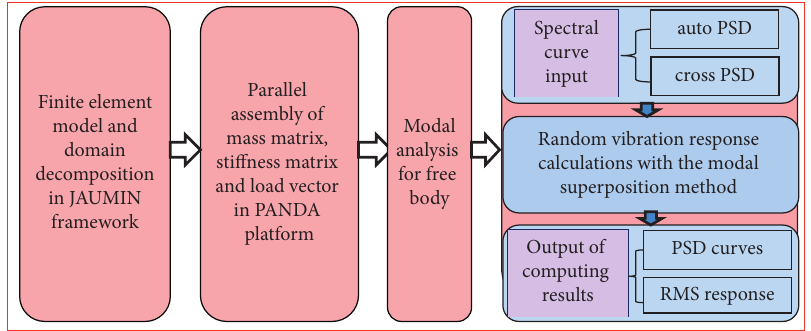
Figure 5: The basic calculation process of free-body random vibration analysis.